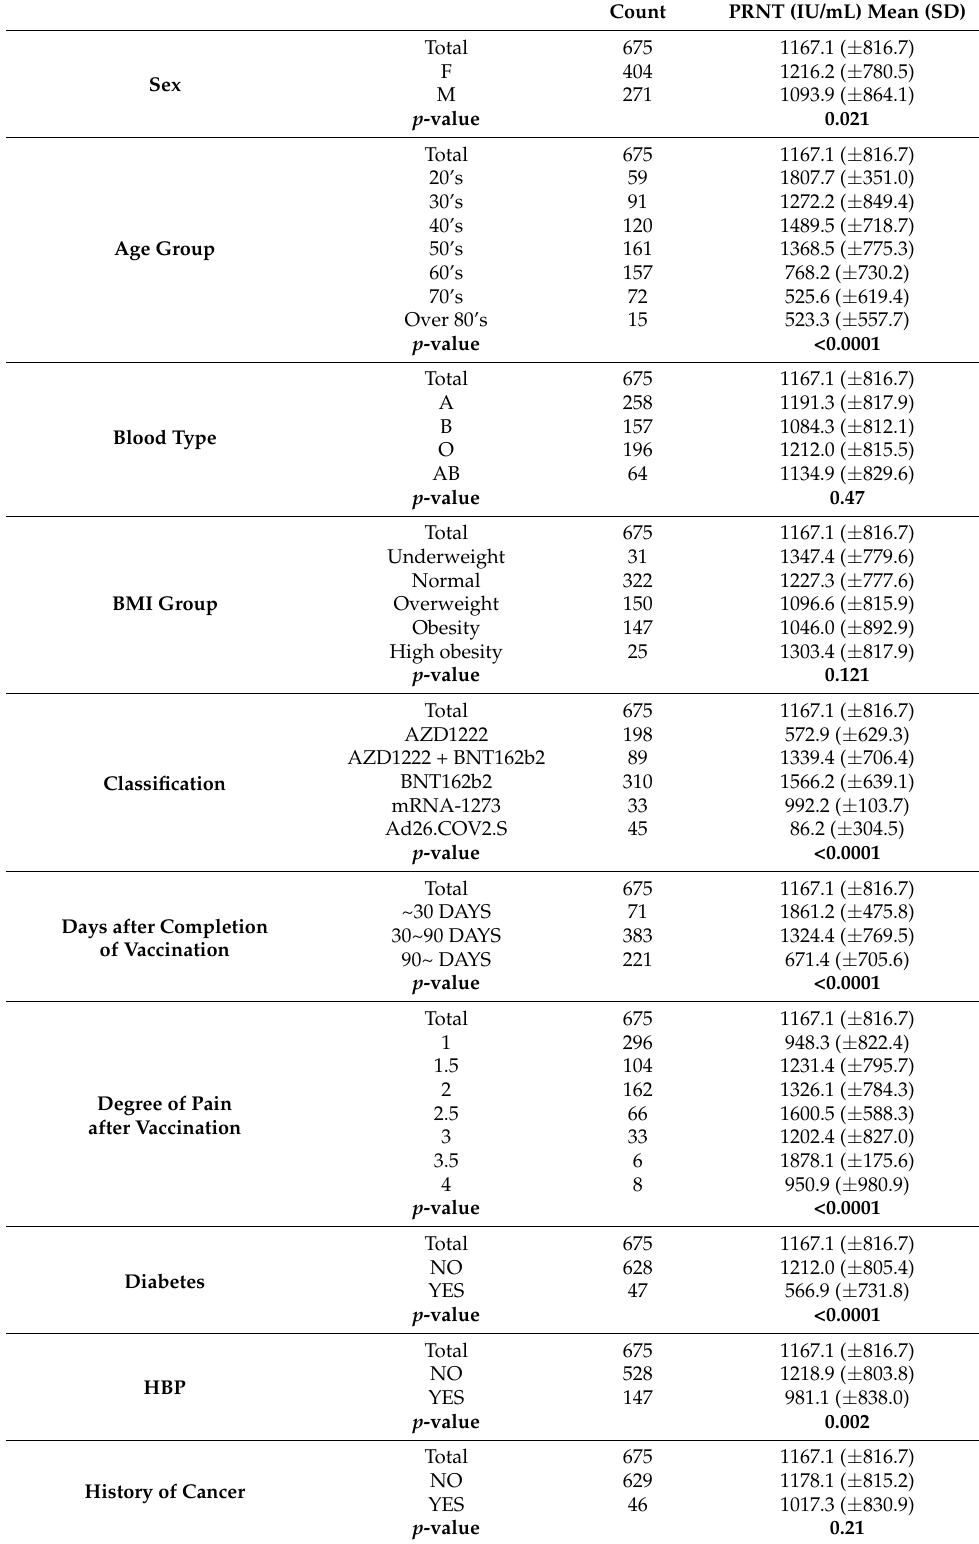
Table 3. Production of neutralizing antibody according to vaccine type, pain, duration, blood type, and major chronic